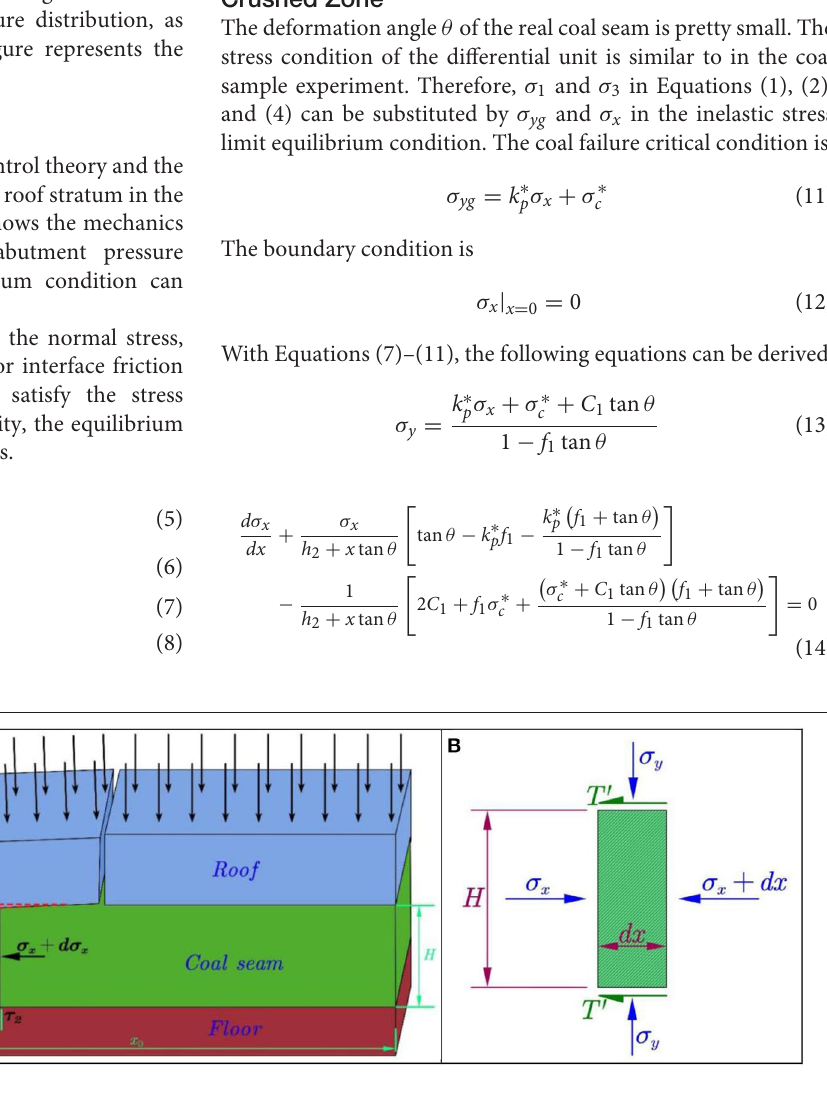
FIGURE 3 | Coal mechanics model in inelastic and elastic condition. (A) Inelastic mechanics model. (B) Elastic mechanics model.